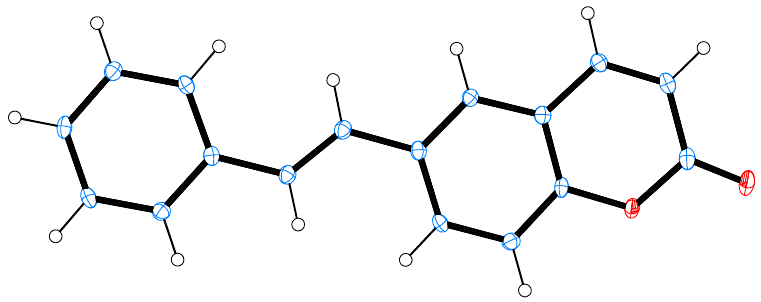
Figure 2. A view of trans -6-styrylcoumarin. Displacement ellipsoids are drawn at the 50% level.